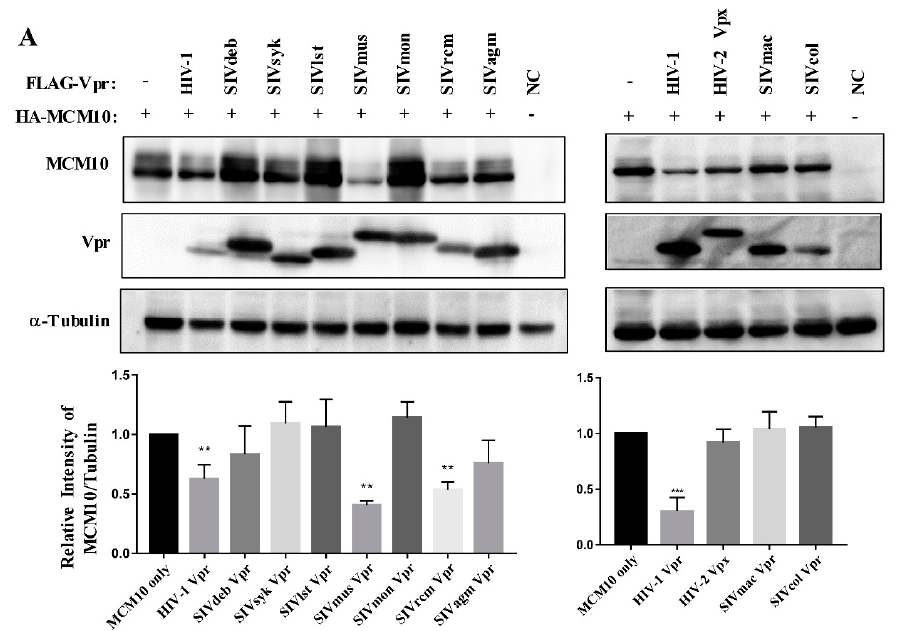
Figure 1. Phylogeny of 96 primate lentiviruses Vprs and multiple alignment and expression of